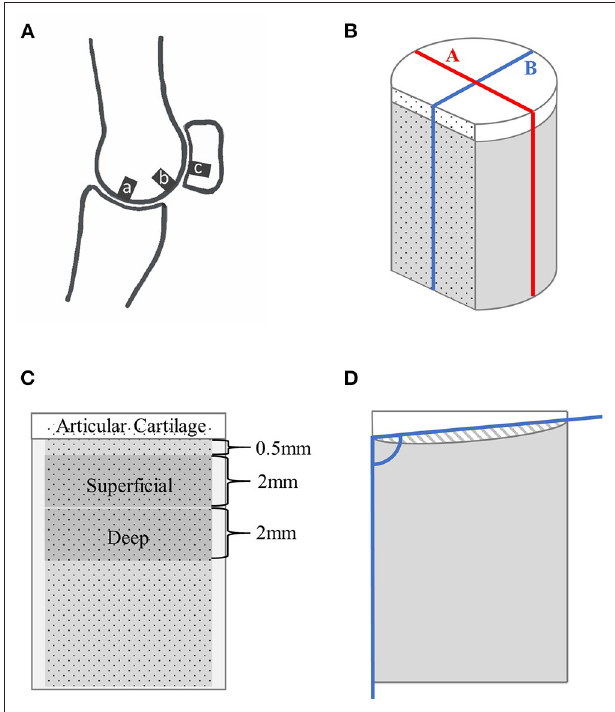
FIGURE 1 | Schematic drawings showing the locations of specimen collection within a fetlock joint (A) and of a cartilage-bone specimen where nonmineralized cartilage is represented in white, and mineralized tissue in gray (B–D) . (A) Parasagittal view through the lateral condyle of a fetlock joint, where ‘a’ is the disto-dorsal MCIII, ‘b’ the disto-palmar MCIII, and ‘c’ the proximal sesamoid specimen collection sites. (B) The cylindrical specimen with a flat cut face, and lines ‘A’ and ‘B’. (C) View of the stained face showing the 2mm thick superficial and deep layers. (D) Sagittal view along line ‘B’ showing the angle used to calculate mineralized tissue surface angle, and the cross-sectional shaded area of hyaline cartilage used to measure surface evenness.